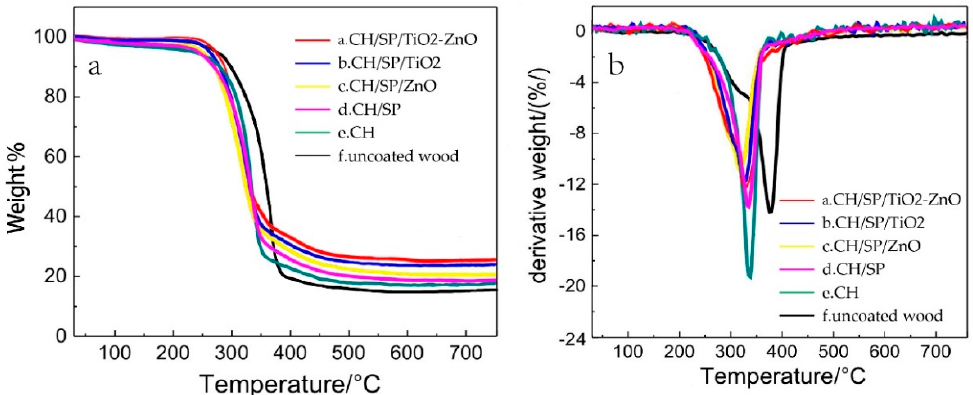
Figure 3. TG ( a ) and DTG ( b ) curves of the uncoated wood (black line), CH coated (green line), CH/SP coated (purple line), CH/SP/nano-ZnO coated (yellow line), CH/SP/nano-TiO 2 coated (blue line), and CH/SP/nano-TiO 2 -ZnO coated (red line) samples.